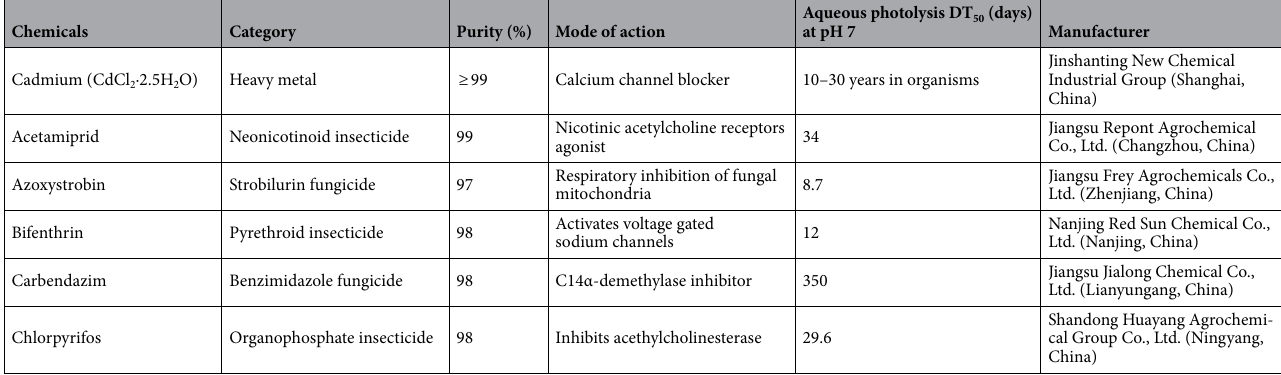
Table 1. Detailed information about the chemical tested in this